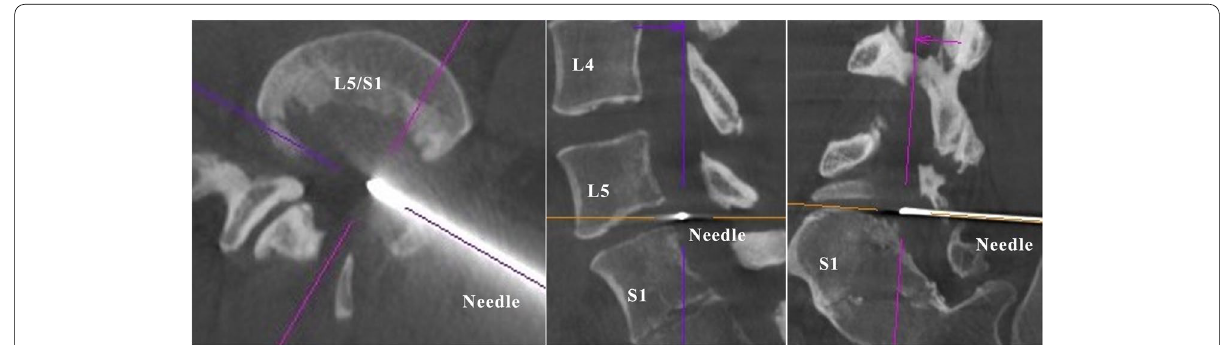
Fig. 3 Multiplanar reconstructions for needle guidance. The real-time needle trajectory is confirmed in the axial, sagittal, and coronal oblique planes